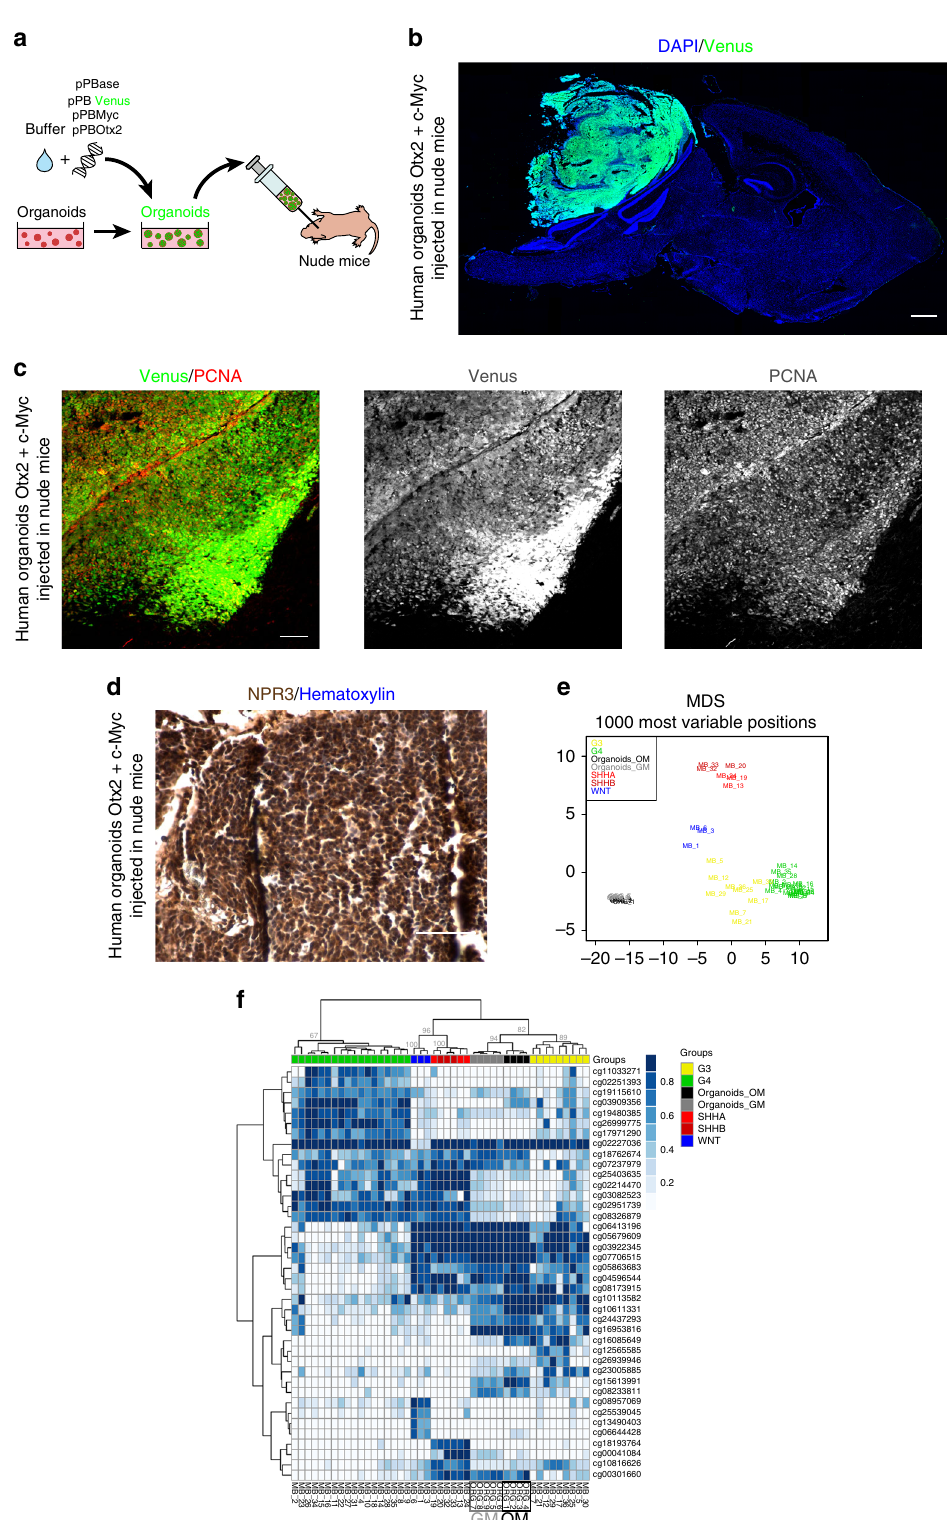
ethical regulations for animal testing and research. The experiments were approved by the Italian Ministry of Health as conforming to the relevant regulatory